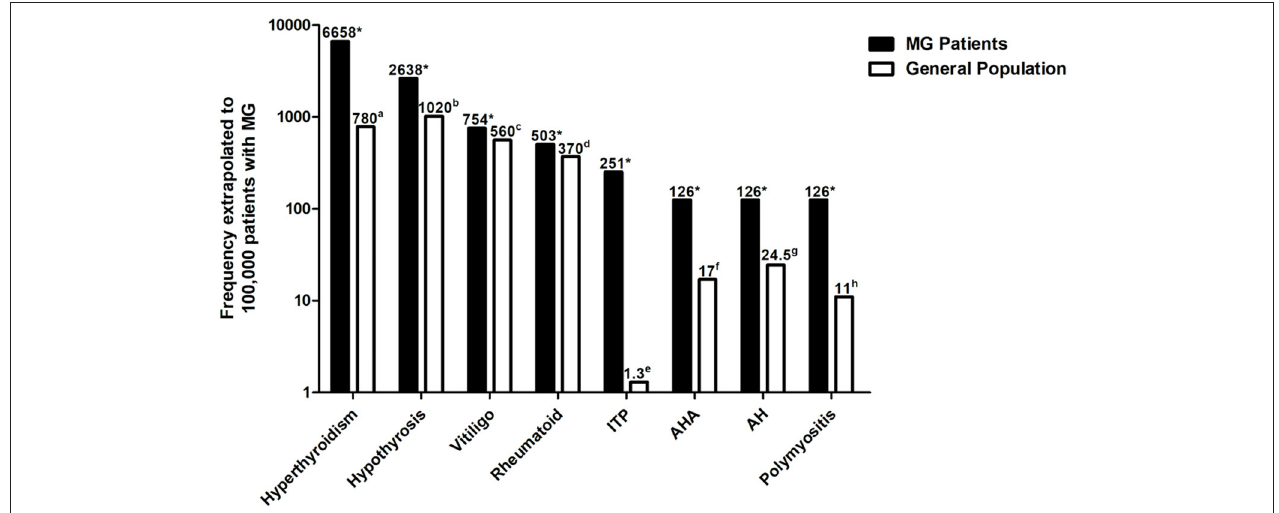
FIGURE 4 | Percentage of each observed AD was extrapolated to 100,000 patients with MG and compared to the prevalence of the disease in the general population. Autoimmune diseases with a significantly higher percentage in patients with MG compared to the general population are shown. The Y-axis is in logarithmic scale. a Data derived from Li et al. ( 17); b data derived from Li et al. (17); c data derived from Wang et al. (18); d data derived from Xiang et al. (20); e data derived from Mariotte et al. (22); f data derived from Hansen et al. (23); g data derived from Ngu et al. (24); h data derived from Essouma et al. (25); * p < 0.05 vs. the prevalence of the disease in the general population. ADs, Autoimmune diseases; MG, Myasthenia gravis.